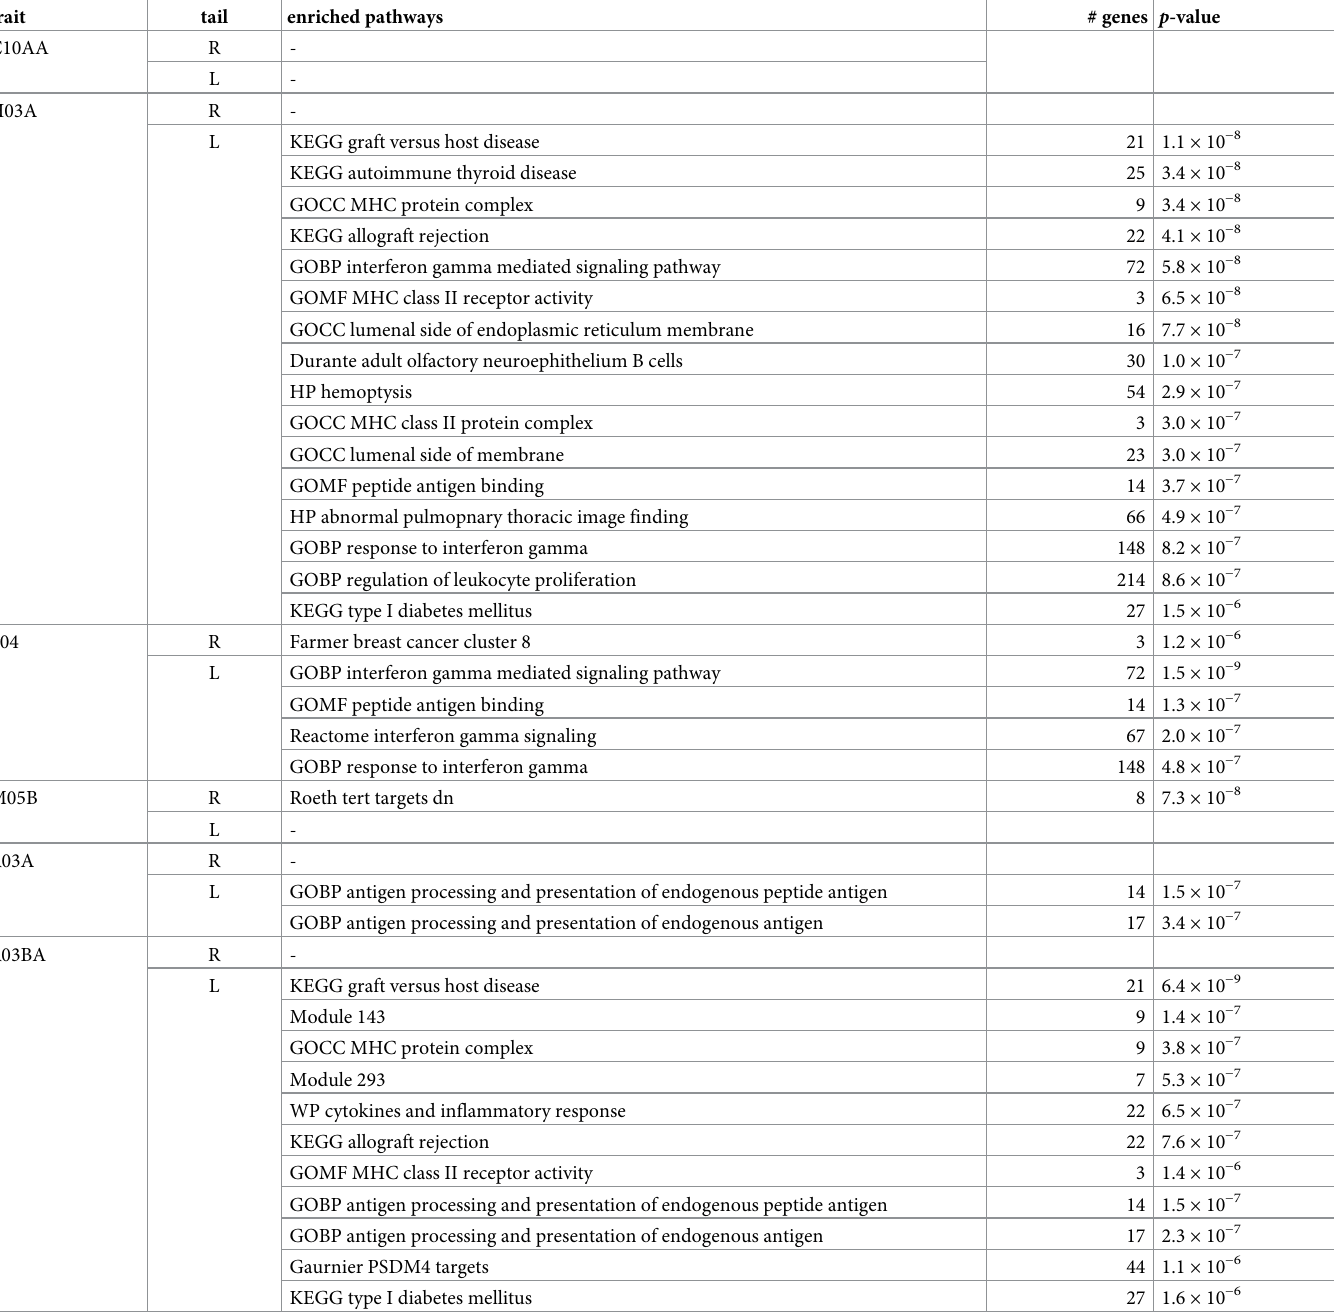
Table 1. Bonferroni significant pathways for cross-scored severe COVID-19 genes. We only tested the six listed traits for pathway enrichment as these traits possess sig- nificant or close to significant genes under the coherence test. The coherent case corresponds to the right (R) tail, the anti-coherent case to the left (L) tail. The number of genes in the pathway is given in the fourth column. We tested against the 32284 gene sets of MSigDB 7.4. We list Bonferroni significant ( p < 0.05/32284/6 ’ 2.6 × 10 − 7 ) pathways and close to significant